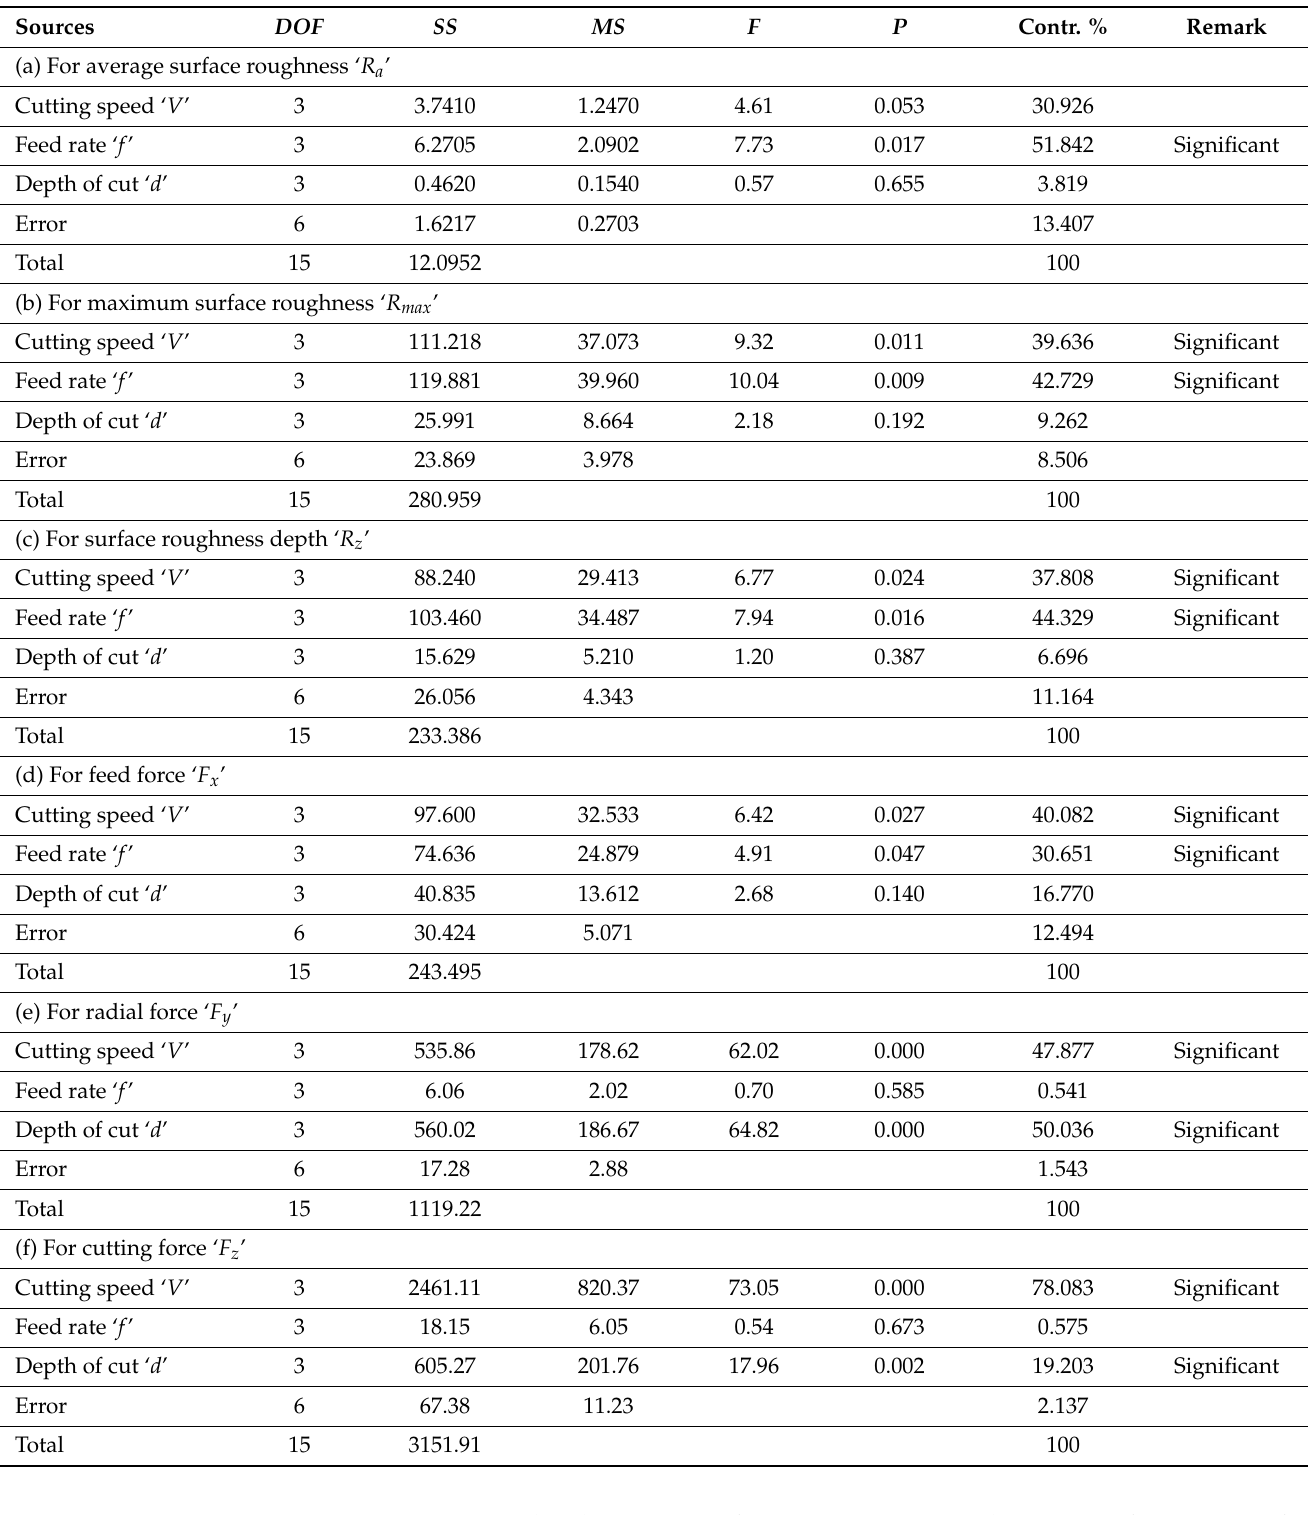
Table 3. Results of ANOVA for average surface roughness (R a ), maximum surface roughness (R max